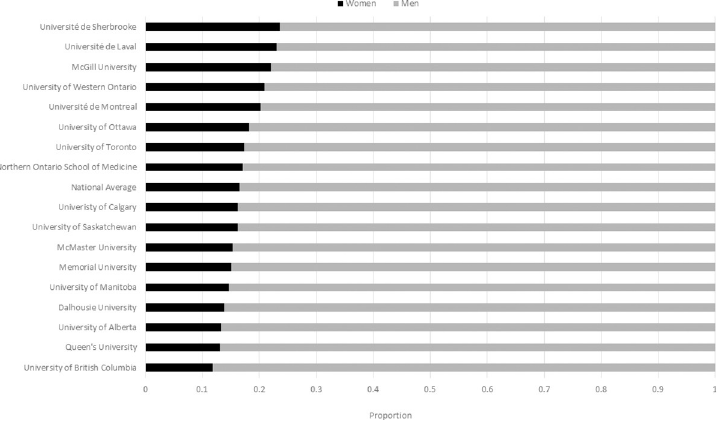
Fig 2. Proportion of women to men academic surgeons by university. Ordered from highest proportion of women surgeons to lowest proportion. Significant differences exist between universities (p < 0.05).